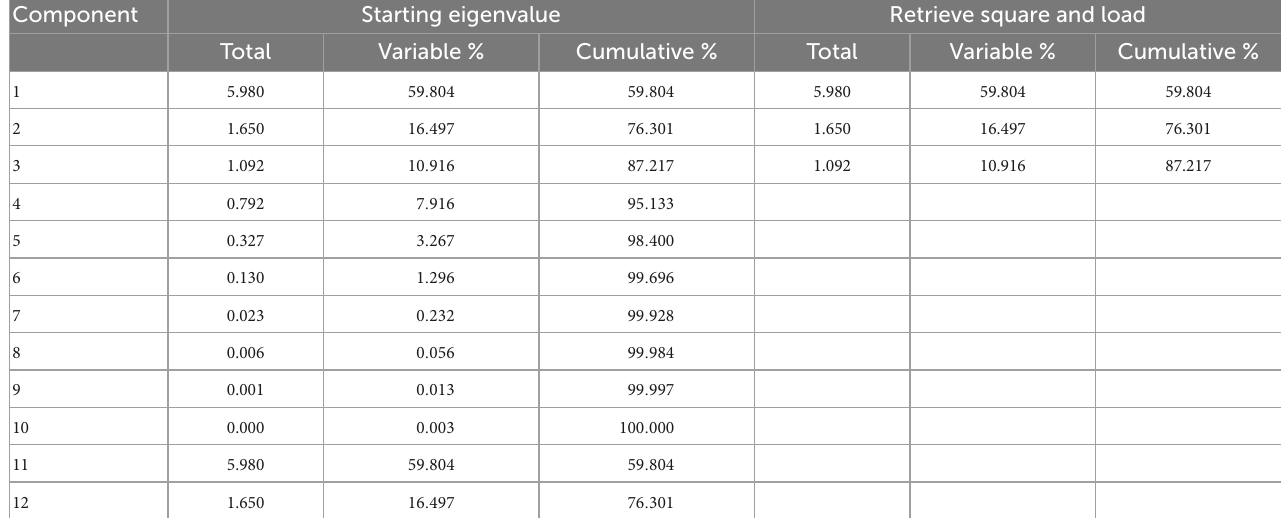
TABLE 4 Principal component analysis.